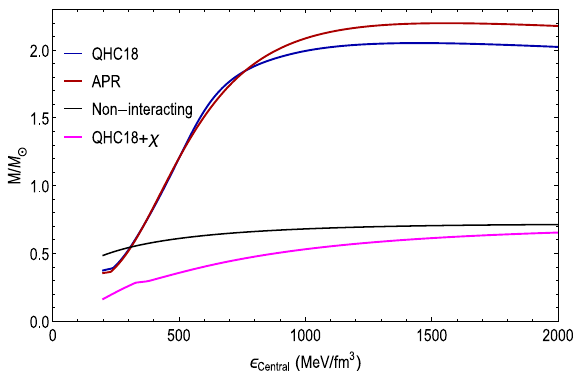
Figure 3. Neutron star masses calculated using the TOV equations for various equations of state: APR [12], QHC18 [13], for non-interacting neutrons and for the QHC18 equation of state with non-interacting dark matter particles in chemical equilibrium. Whereas both the APR and QHC18 equations of state predict maximum neutron star masses consistent with observations, the addition of the non-interacting dark matter degree of freedom reduces the maximum mass to that of the non-interacting bound (at very high central energy densities). Note that the APR + χ equation of state gives masses only slightly higher than those of QHC18+ χ . The flat regions at low central density correspond to pion condensation in the underlying nuclear equation of